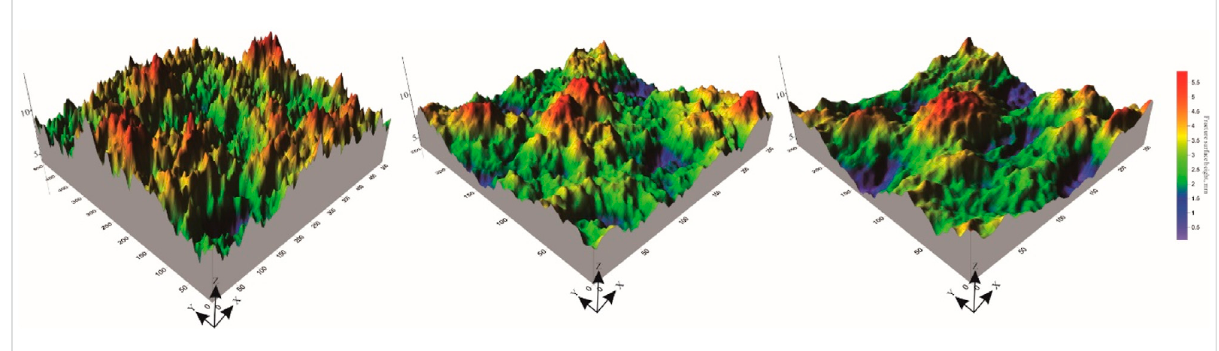
FIGURE 2 Features of generated fracture surfaces.